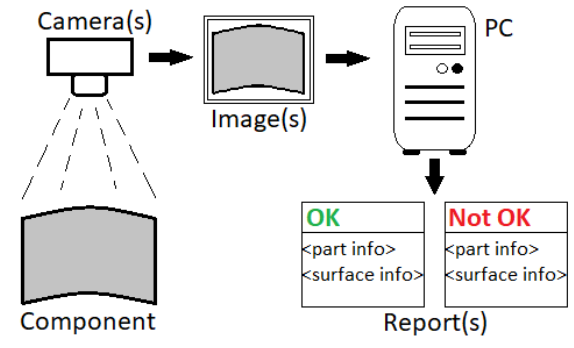
Figure 12. Camera setup